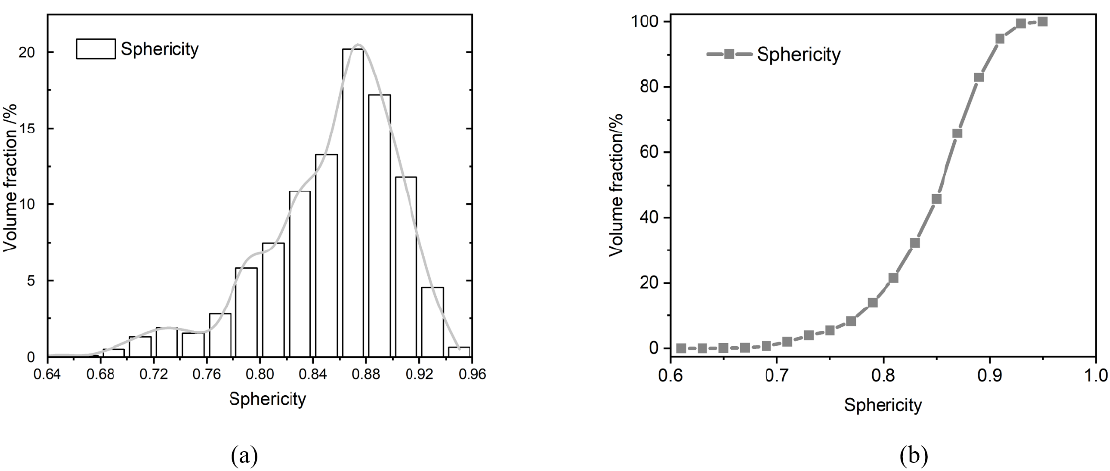
Figure 9. Volume-based distribution histogram of sphericity, S : ( a ) differential; ( b ) cumulative.